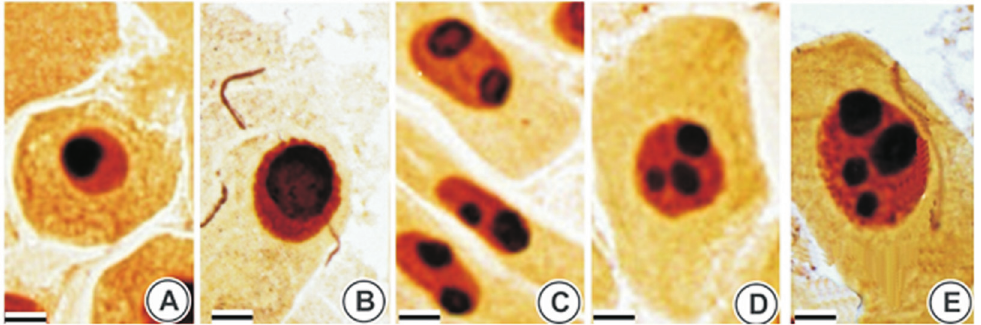
Figure2 -Meristematiccellsof Alliumcepa germinatedinthenegativecontrol(NC)and1000mg/LTiO 2 NPsubjectedtoAg-NORstainingandbanding. (A) Nucleoli germinated in NC, (B-E) cells germinated in 1000 mg/L TiO 2 NP, (B) increased size nucleoli, (C) two nucleoli, (D) three nucleoli, (D) four nucleoli. Scale bars 20 (cid:3) m.